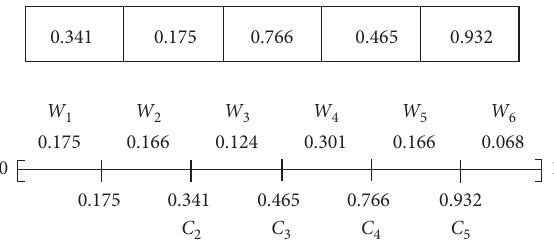
Figure 1: Example showing the encoding and decoding mecha- nisms of several